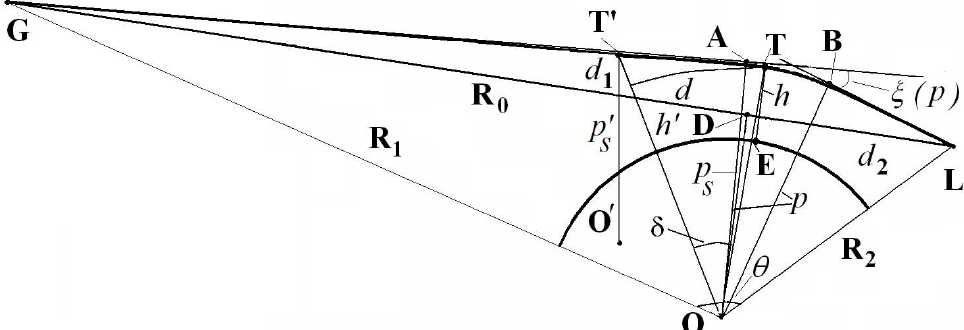
Fig. 1. Geometry of radio ray path in RO